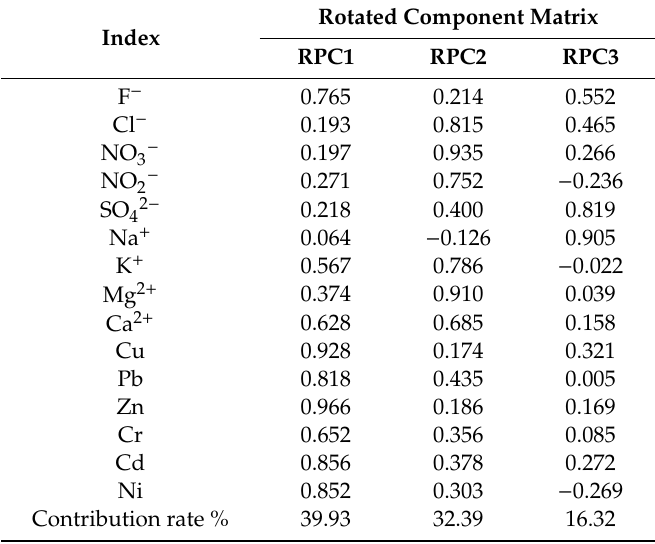
Table 5. Principal component analysis (PCA) matrix of WSIIs and heavy